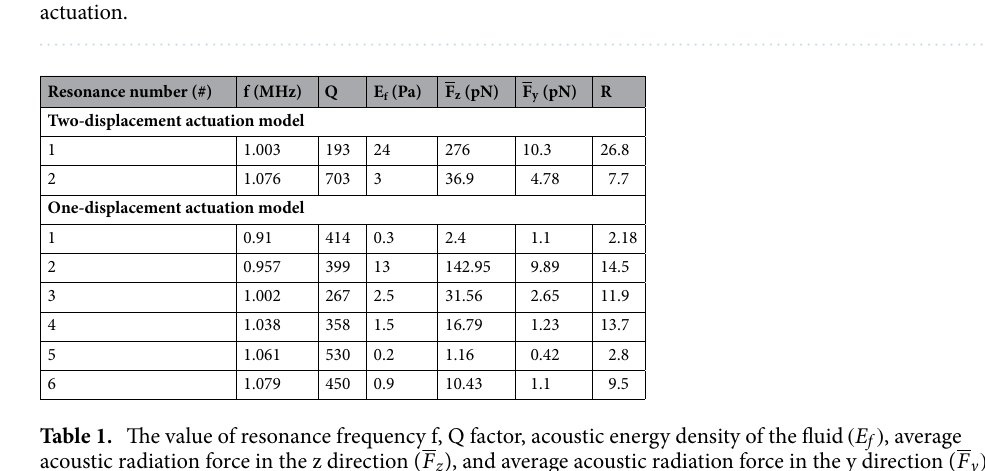
Figure 1d,f confirm that most of the acoustic energy is accumulated in the solid domain at the higher resonances. The spatial average of the acoustic radiation force components applied on 25 µm particles are plotted in Fig. 1f,g. In all the resonances, the spatial average acoustic radiation force in the z direction ( F z ) conducts par- ticles toward the nodal plane, with a value much larger than the force component in the y direction ( F y ). The greater the F z compared to F y , the better the acoustophoretic property of the device, quantified by the ratio of 50 . The resonances with higher R values offer stronger horizontal acoustic radiation F z to F y defined as R = − F z F y forces. R values for each of the resonances in both one-displacement and two-displacement actuation systems are presented in Table 1. The R value of the resonance #1 in the two-displacement actuation system has the high- est value among R values at other resonance frequencies, wherein the acoustic energy is focused on the fluid domain, generating a higher acoustic pressure amplitude and stronger acoustic radiation force in the z direction. The simulation results show that anti-symmetric pressure fields are present at all the resonances of the two- displacement actuation model, but the wave node where pressure is zero is not exactly located in centerline of the fluid cavity in the one-displacement actuation model. Figure 2 shows anti-symmetric pressure fields for two-displacement actuation’s resonance of 1.003 MHz (Fig. 2a) and one-displacement actuation’s resonances